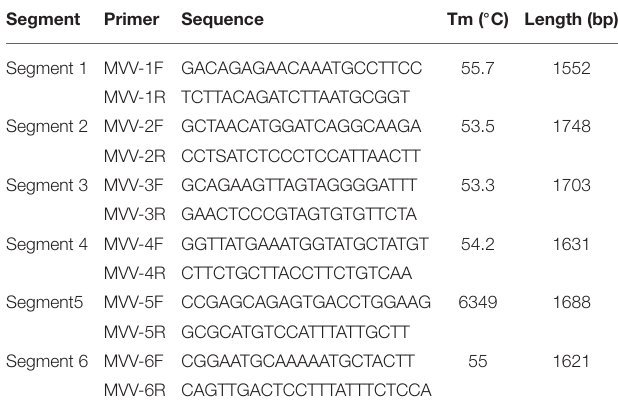
TABLE 2 | List of Visna/Maedi virus used in the complete genome